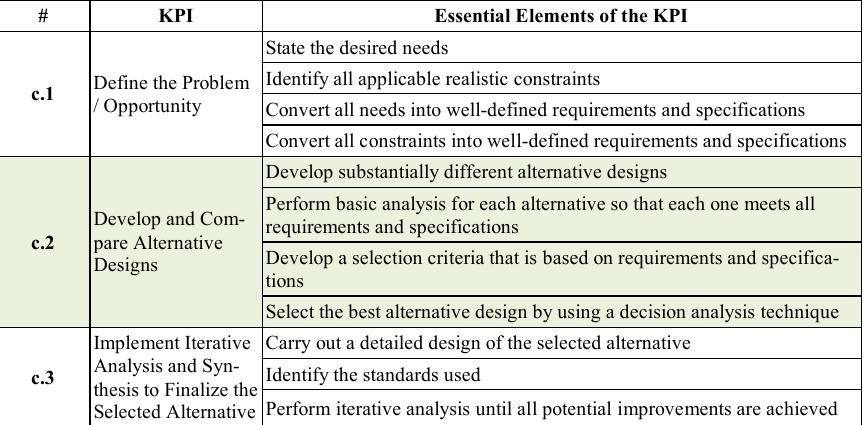
Table 5. Sample of KPI for ABET outcomes (rubrics)